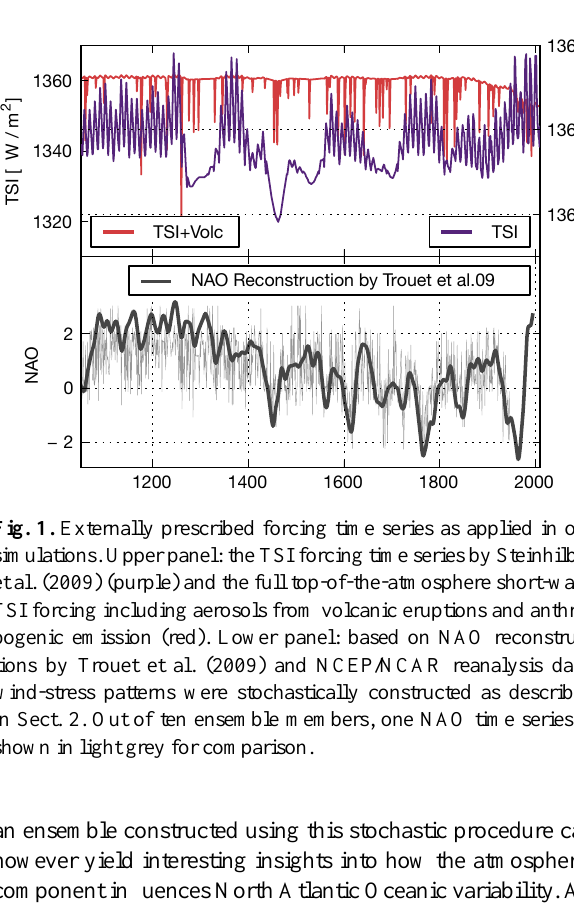
Fig. 2. Transient model results of the last millennium with pre- scribed TSI, CO 2 and wind-stress forcing applied. (a) The North Atlantic Sea-Ice Extent (NASIE) for an ensemble with an additional 5mSv freshwater offset in the Nordic Seas (blue) and without fresh- water offset (red, individual ensemble members in light red, thick lines: ensemble mean). (b) depicts the SPG dynamics and (c) the AMOC at 30N. (d) AMO anomalies in comparison with the recon- structed AMO index by Mann et al. (2009).